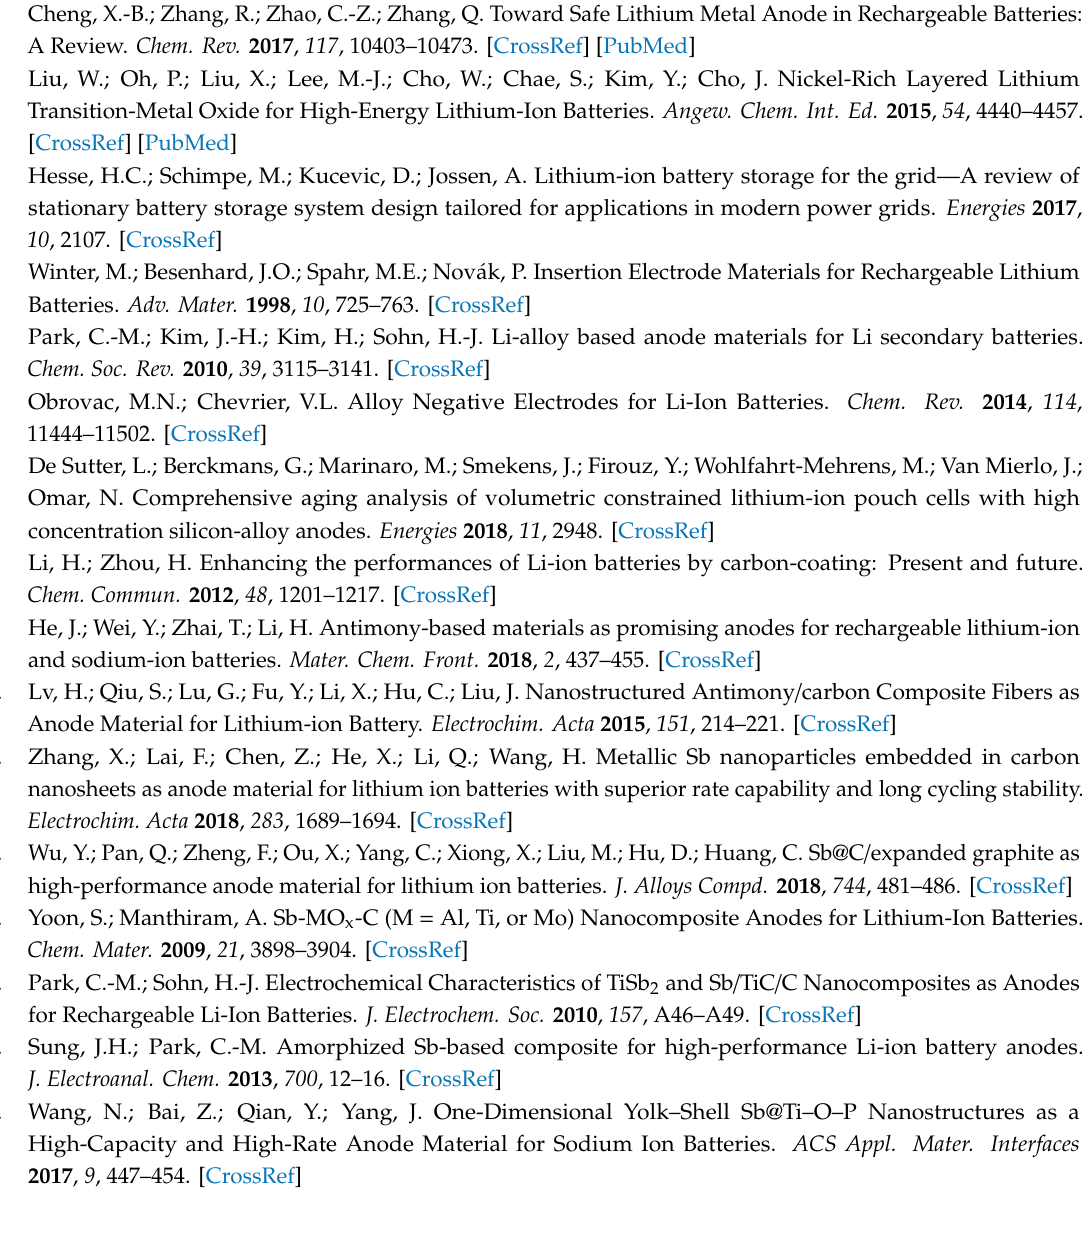
Figure S1: Raman spectrum of the synthesized material, Figure S2: TGA curve of the synthesized material, Figure S3: CV curves of the Sb core / Nb 2 O 5 -C double-shell structured composite electrode, Figure S4: Cycle performance of the pure Sb and mixture